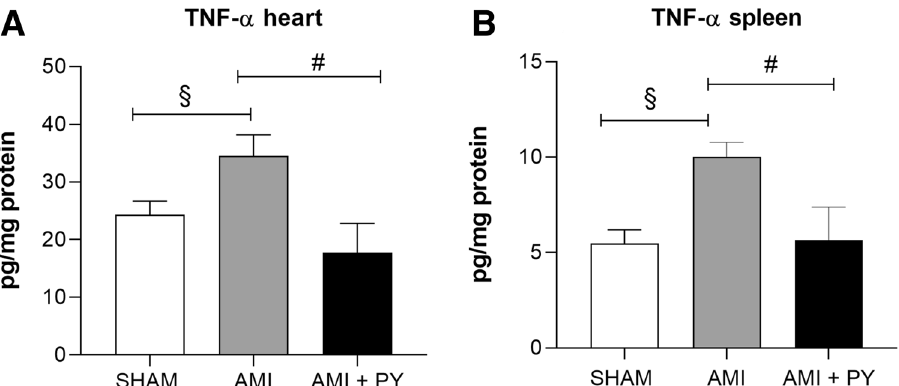
Figure 8. TNF levels in the heart ( A ) and the spleen ( B ) in all groups. # p < 0.05; § P < 0.05 statistically significant. Values expressed as mean ± SEM. One-way ANOVA. § AMI versus Sham; # AMI + PY versus AMI. Values expressed as mean ± SEM. Statistical significance was determined by one-way ANOVA followed by a multiple comparisons test Tukey’s was performed using GraphPad Prism version 9.0.1. www. graph pad.